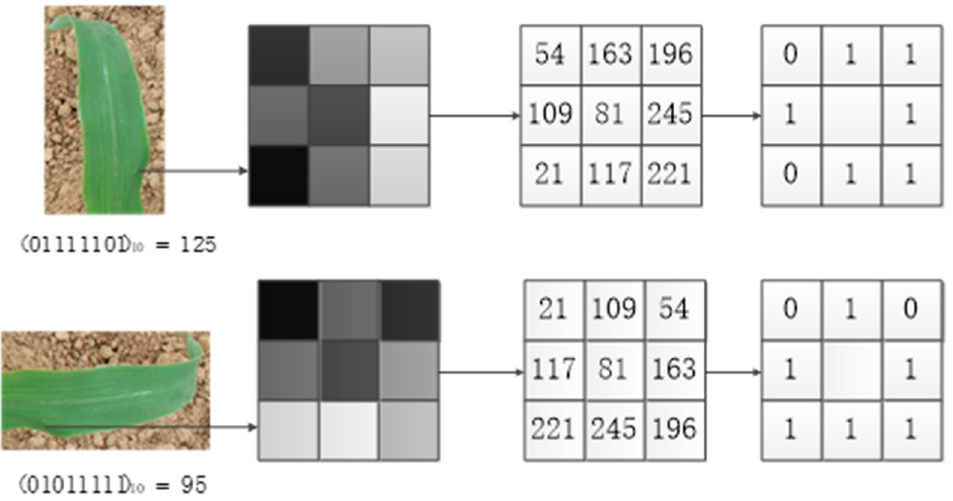
Figure 6. Schematic diagram of rotation invariant local binary pattern (RotLBP).